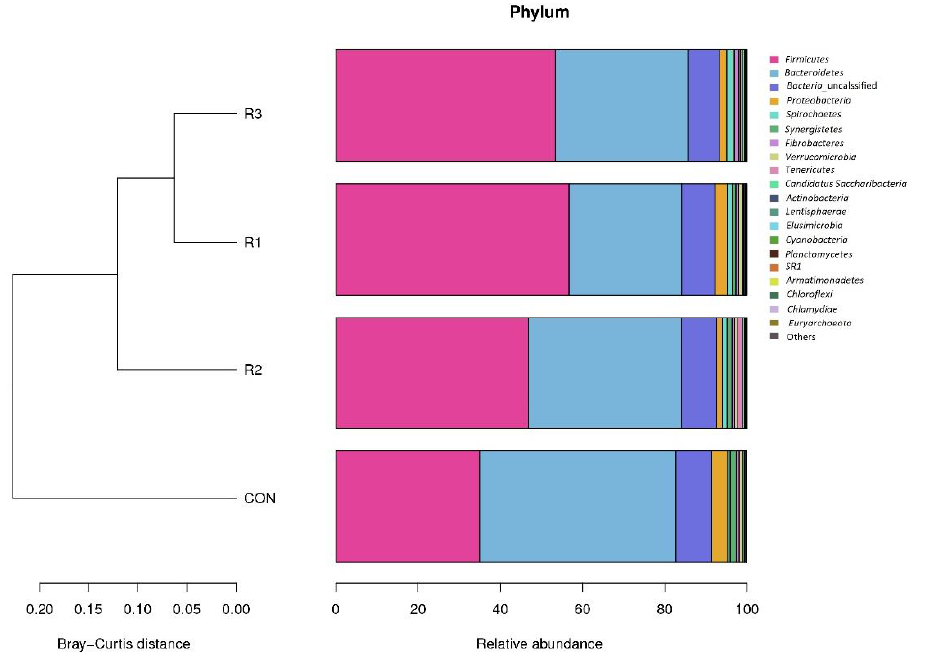
Figure 2. The relative abundance at the phylum level of rumen microbial communities in goats fed with corn and ramie. CON, corn silage; R1, 1 cm chopped ramie silage; R2, 2 cm chopped ramie silage; R3, 3 cm chopped ramie silage.